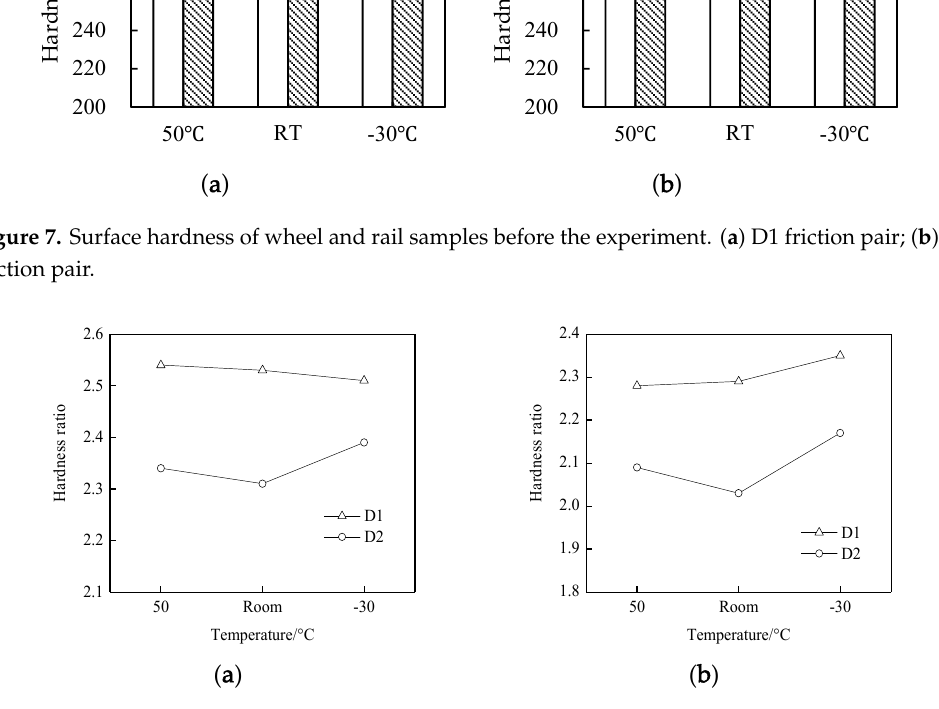
Figure 8. Surface hardness ratios of wheel and rail samples of values measured after and before the experiment:.(a) ratios of hardness values of the wheel measured after the experiment and before the experiment; (b) ratios of hardness values of the rail measured after the experiment and before the experiment.